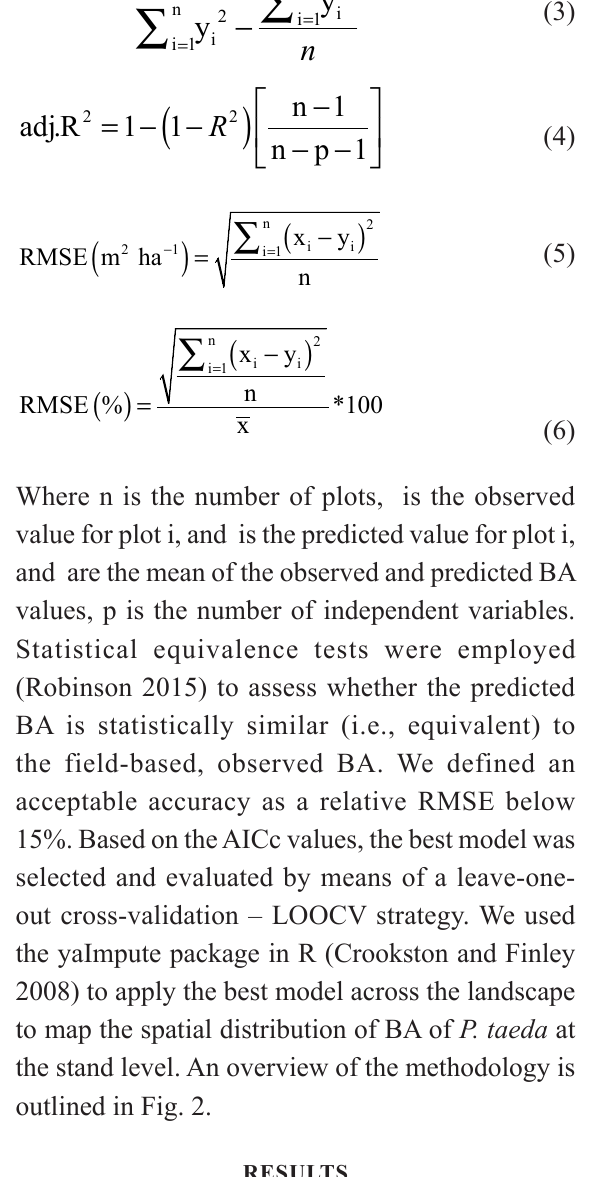
LiDAR-derived metrics considered as candidate variables for Basal Area (BA) modeling (McGaughey